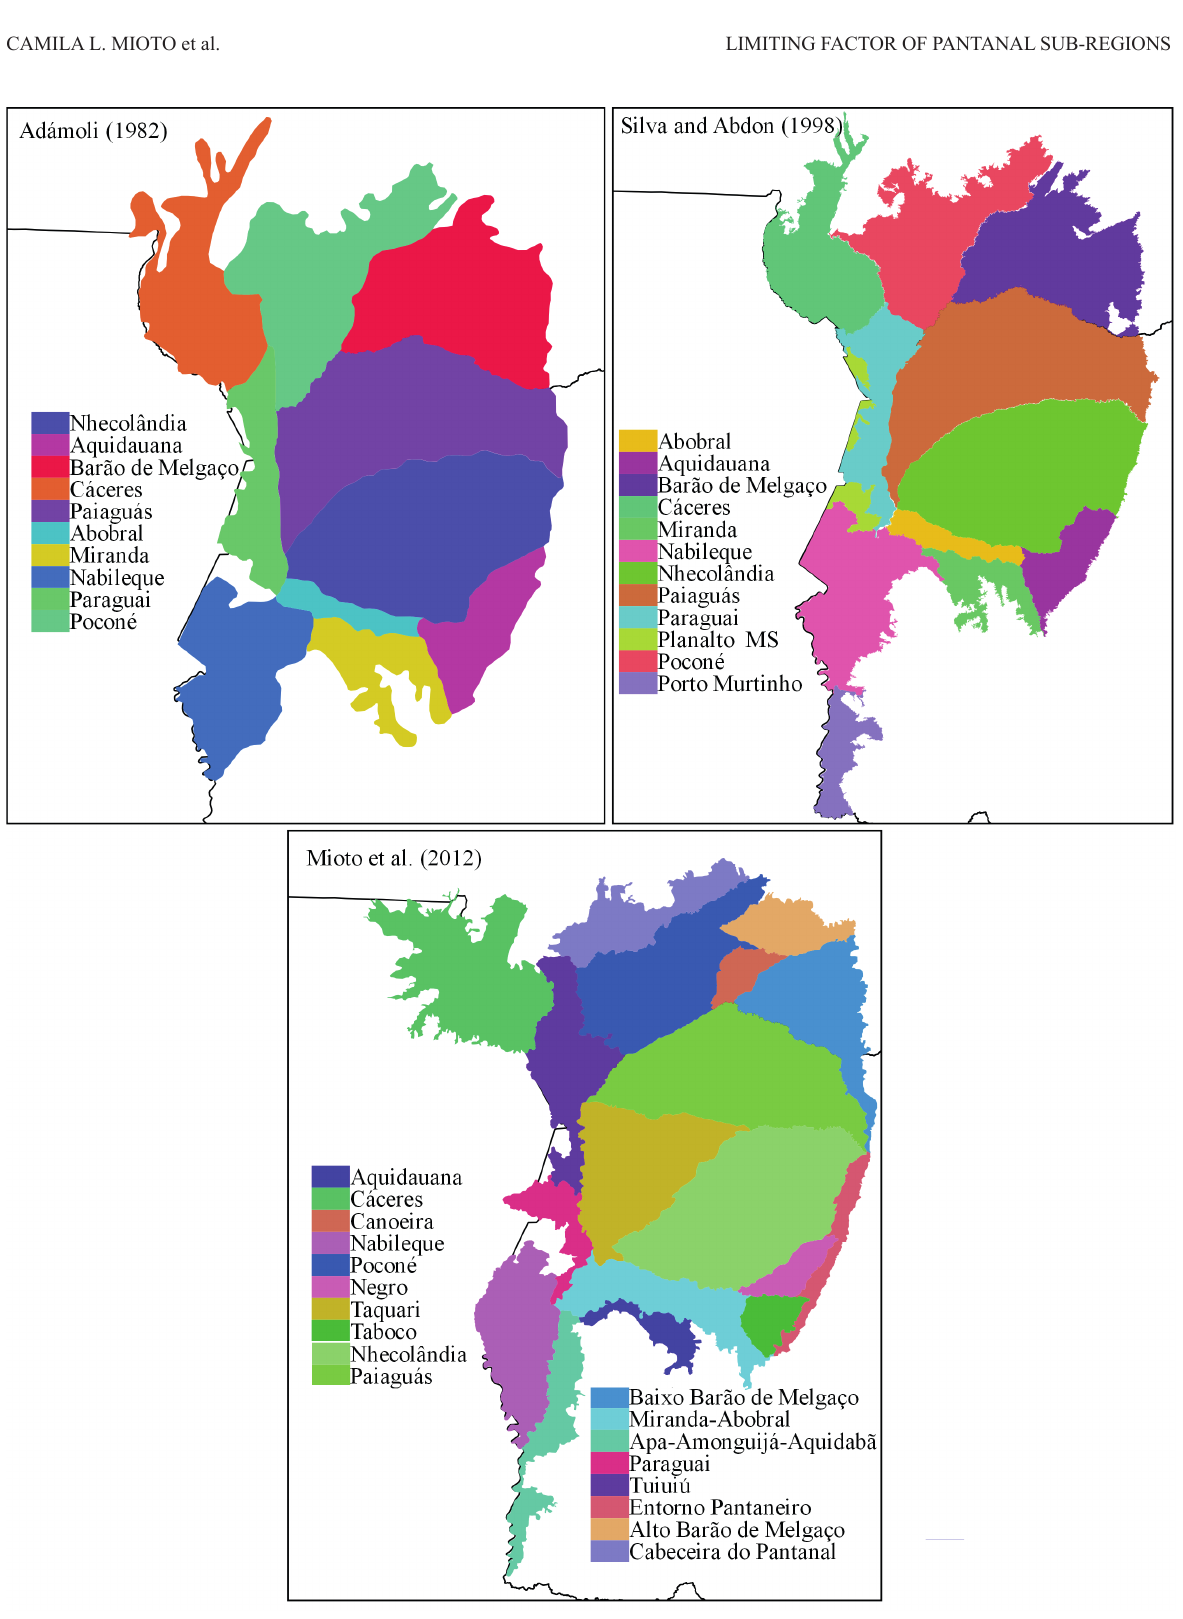
Figure 3 - the boundaries of the Pantanal sub-regions used in this